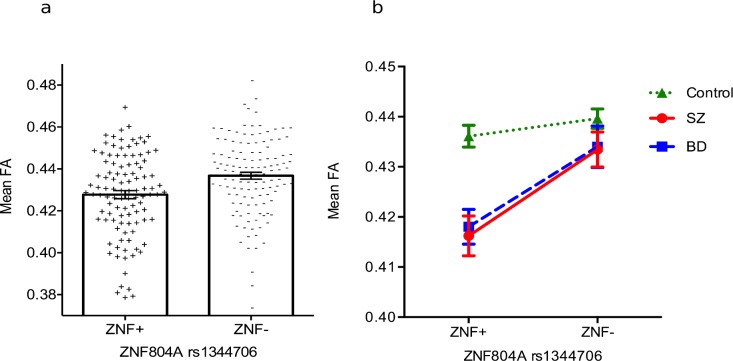
Main effect of rs1344706 genotype on fractional anisotropy.(A) FA was significantly lower in the high-risk (A homozygotes; ZNF+) group compared to the low-risk (C-carriers; ZNF−) group (p < 0.05, TFCE-corrected), irrespective of diagnosis in brain areas mapped in Fig. 2. Post-hoc analysis revealed that mean FA of ZNF+ was lower by half of a standard deviation (Cohen’s d = 0.47) than ZNF−, which equates to a ‘medium’-sized effect. (B) Within the largest cluster under a main effect of genotype cluster (44,054 voxels), the effect in SZ (Cohen’s d = 0.83) and BD (Cohen’s d = 0.89) was, all voxels averaged, ‘large’ while the effect in controls was ‘small’ (Cohen’s d = 0.2)—from a post-hoc analysis. As in subsequent figures, ‘Mean FA’ refers to the mean FA of the largest TFCE-corrected significant cluster, rather than to mean FA across the whole brain; with individual data points in “A” representing the mean FA of each individual within the same cluster.